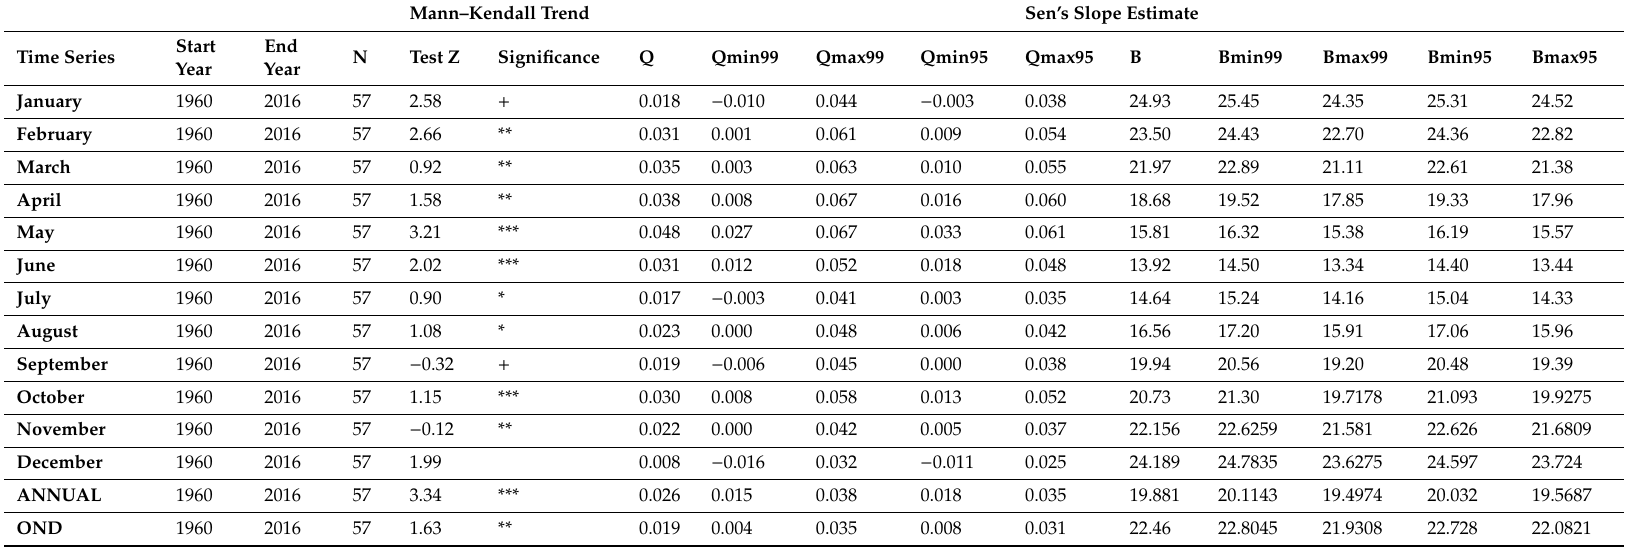
Table 3. Annual average maximum temperature trend